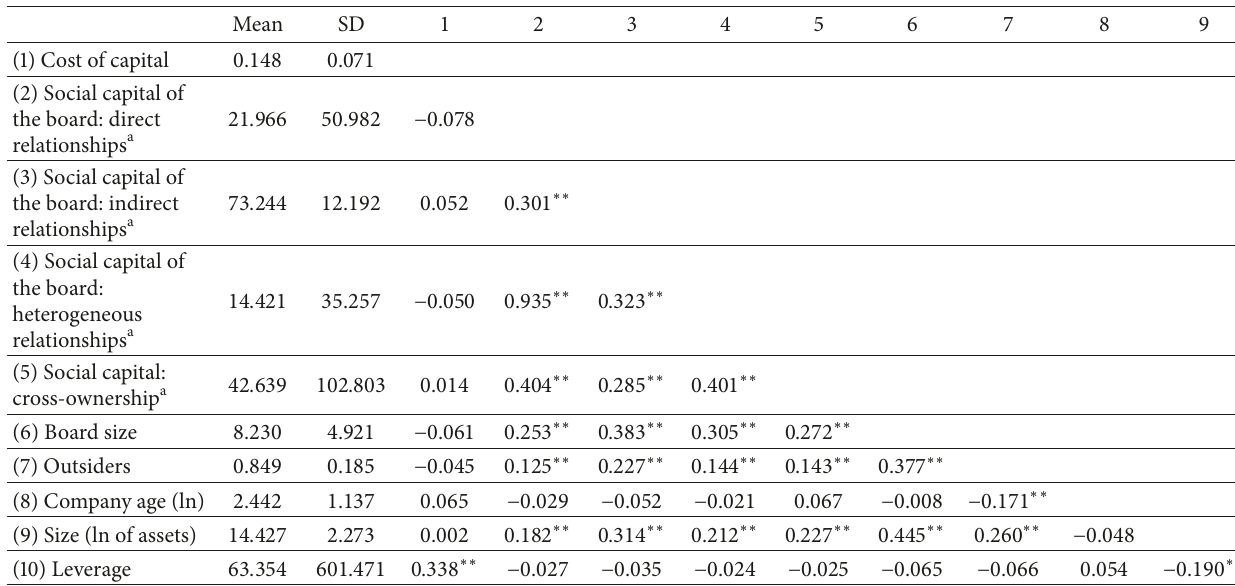
Table 1: Descriptive statistics.